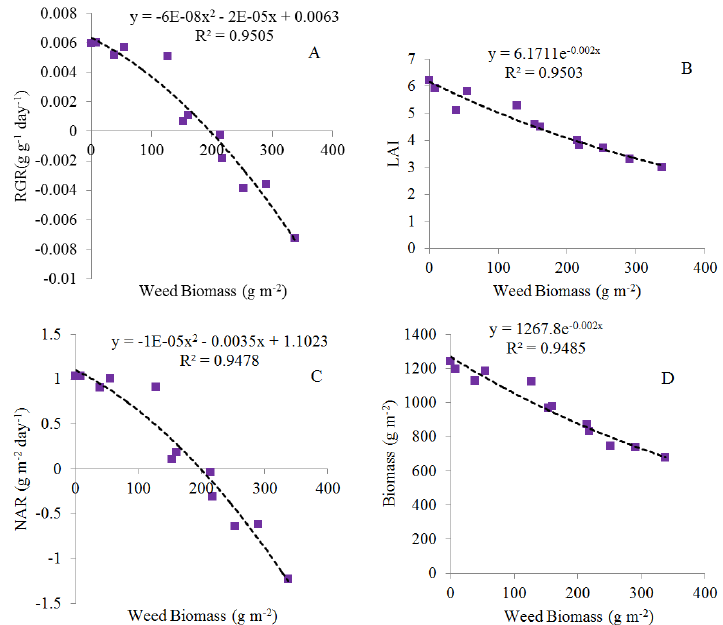
Fig. 6. Relationship between weed biomass and dry bean RGR (A), LAI (B), NAR (C) and biomass